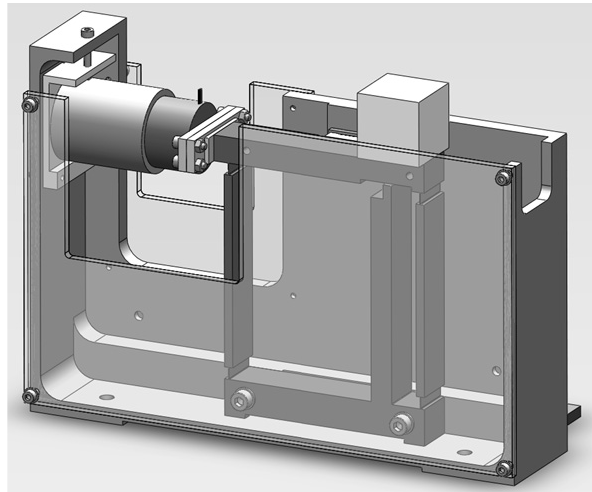
Figure 10. CAD image of the designed actuation sub-brick